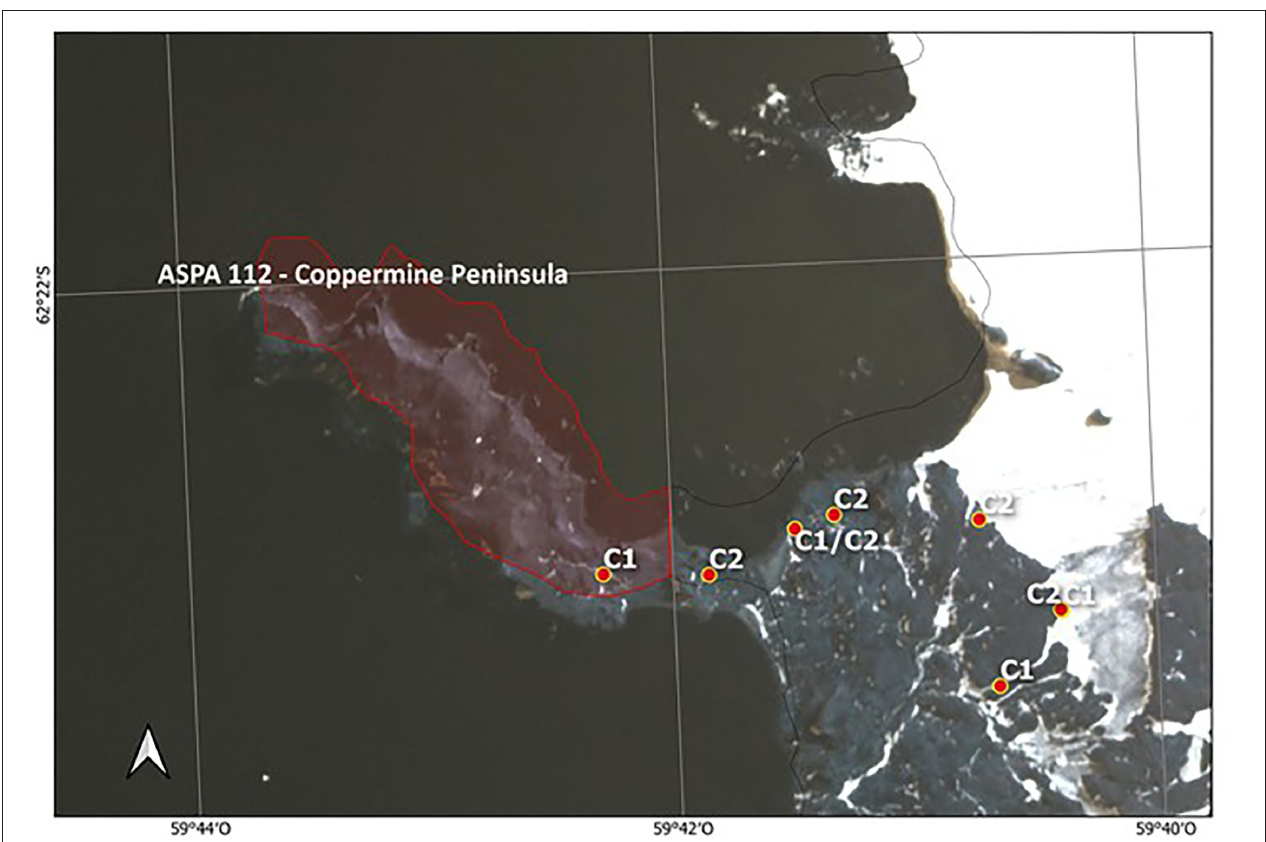
FIGURE 3 | Distribution of two S. uncinata clusters found inside and outside of ASPA 112—Coppermine Peninsula, Robert Island. Labels C1 corresponds to Cluster 1 and C2 to Cluster 2. In this figure, the limits of ASPA 112 are shown to reinforce the conservation deficiency, leaving the other areas as free access.